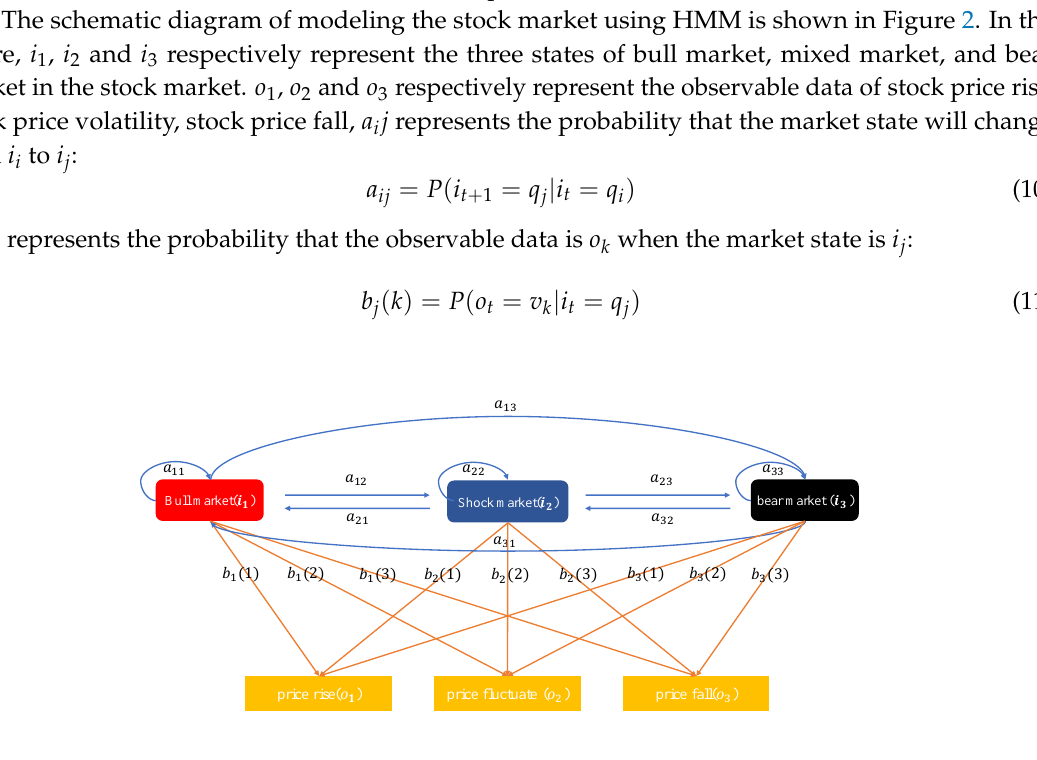
Figure 2. The schematic diagram of modeling the stock market using hidden Markov models